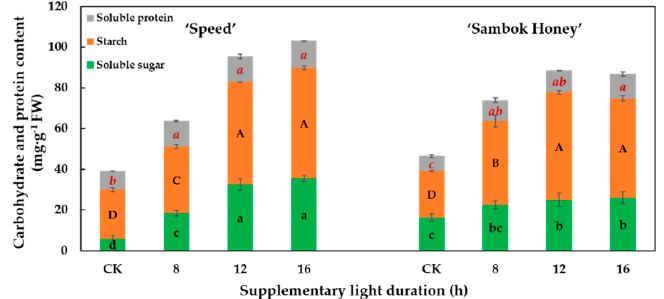
Figure 5. The effects of the supplementary light duration on the contents of soluble sugars, starch and soluble proteins in two cultivars of watermelon, ‘Speed’ and ‘Sambok Honey’, grafted onto ‘RS Dongjanggun’ bottle gourd rootstocks, after 10 days of supplementary light treatments. The error bars represent the SEs of the biological replicates ( n = 3). Mean separation within columns are significantly different according to Tukey’s multiple range test at p = 0.05.